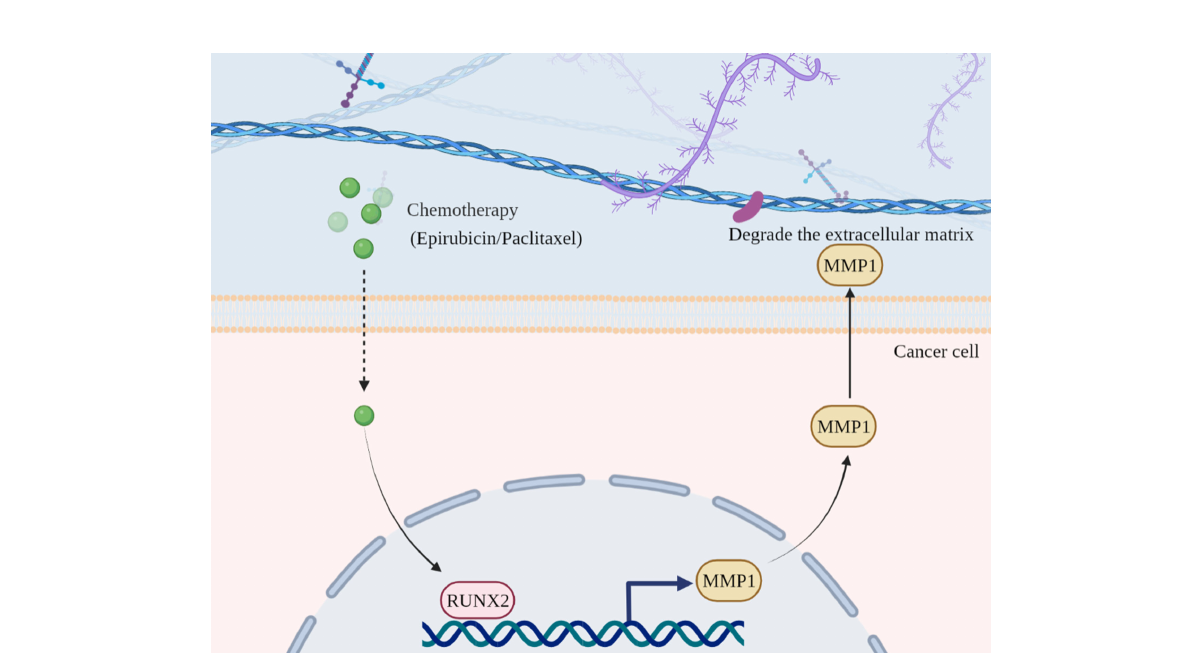
FIGURE 10 Illustration of the working model of RUNX2-MMP1 axis in TNBC. In chemotherapy drug-resistant TNBC, RUNX2 expression was upregulated against Epirubicin treatment. Then, RUNX2 was adequate to directly bind to the speci fi c motif in the promoter region of MMP1 and thus activate MMP1 expression. Finally, the upregulated MMP1 functioned critically in the degradation of ECMs and the resultant modulation of proliferation, metastasis (e.g., migration, invasion) and drug resistance of